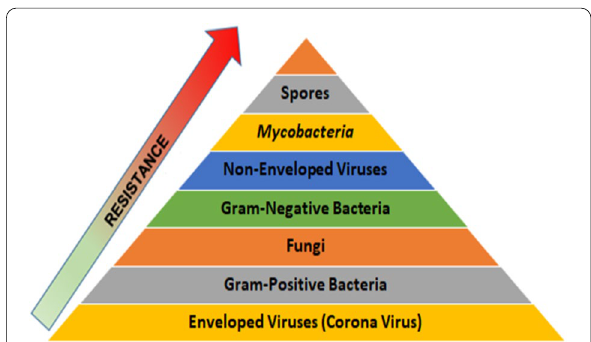
Fig. 1 Resistance of microorganisms to sterilization (William and Weber